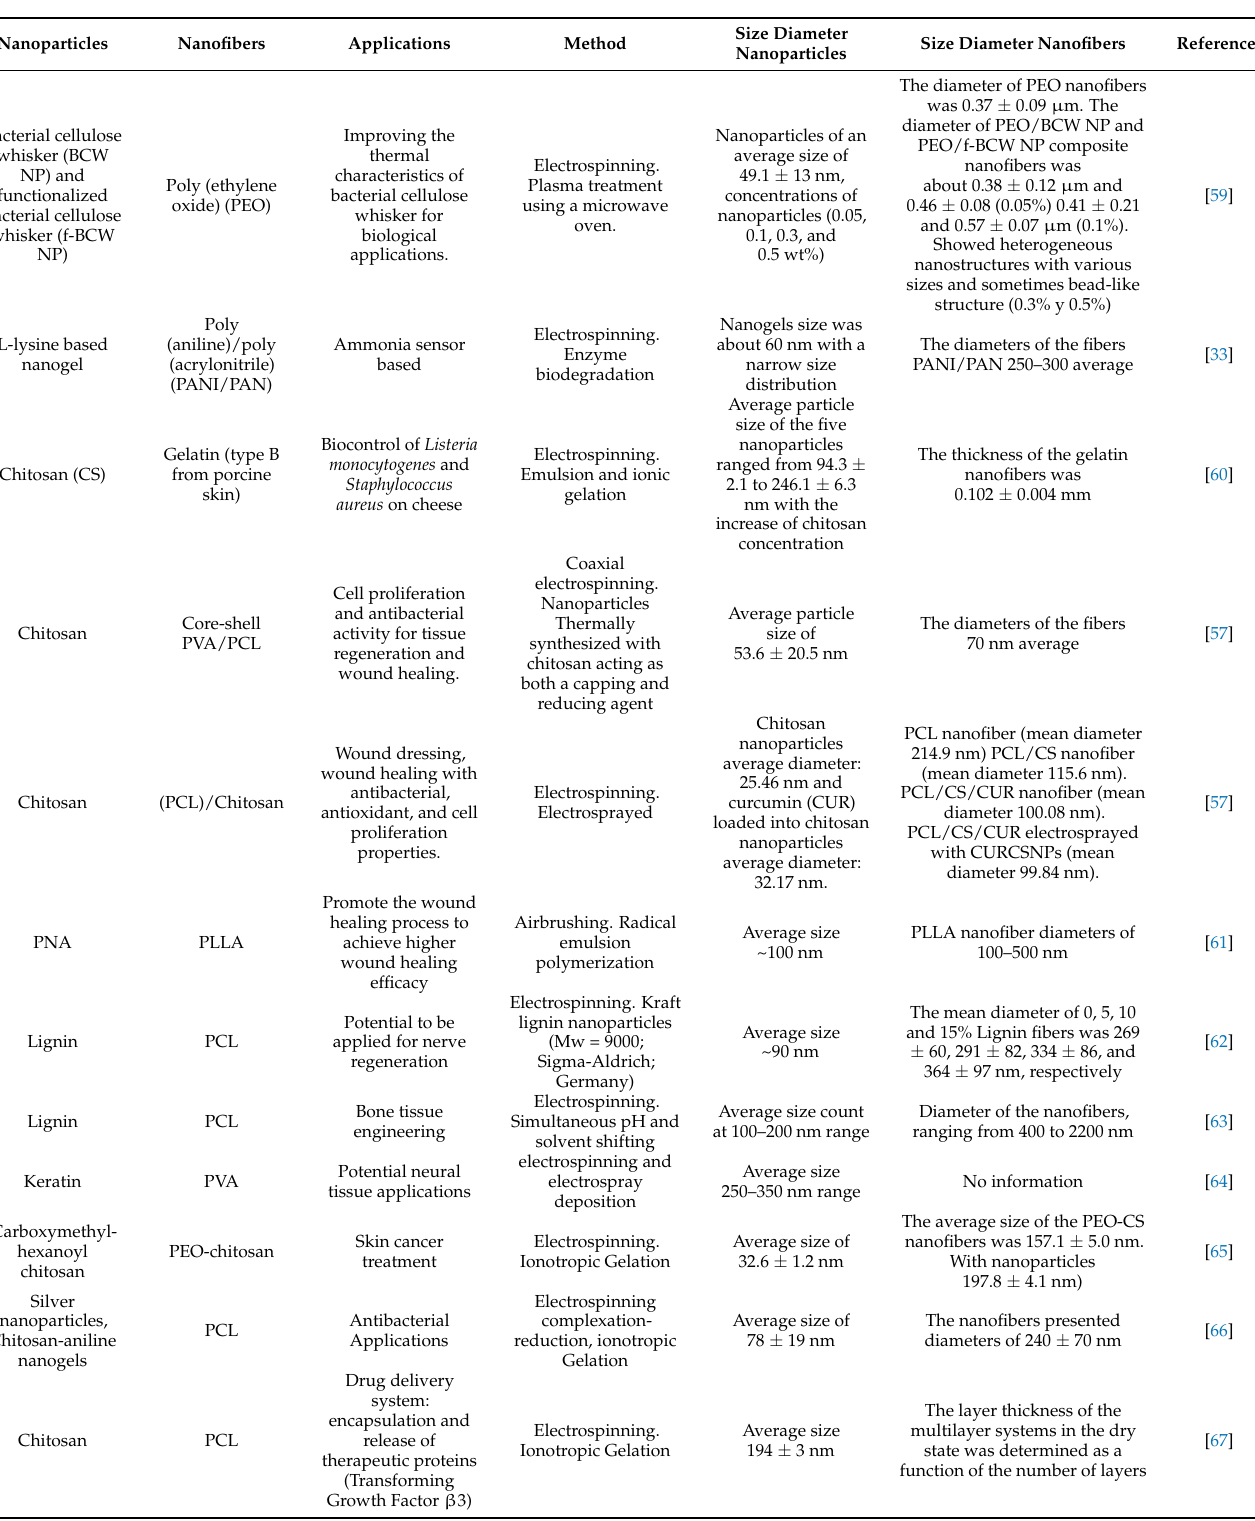
Table 2. Summarized organic nanoparticles/nanofibers hybrid